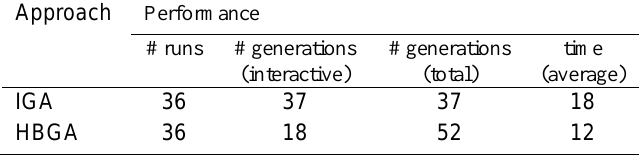
Table 1. Comparison IGA vs. HBGA